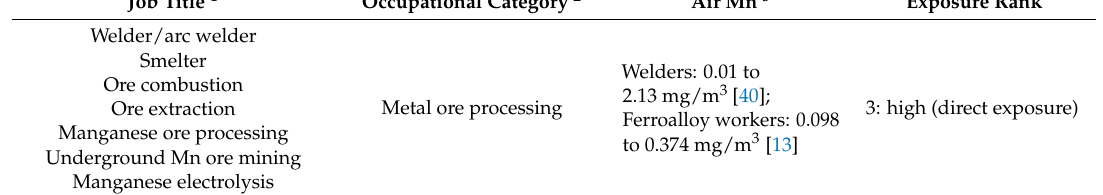
Table A1. The classification of job titles into exposure ranks used in cumulative exposure index (CEI)